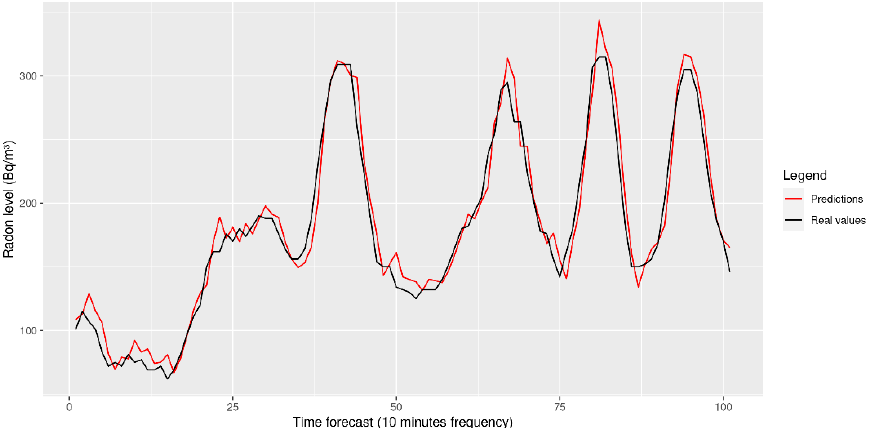
Figure 7. Test signal forecasting using the LSTM model presented.